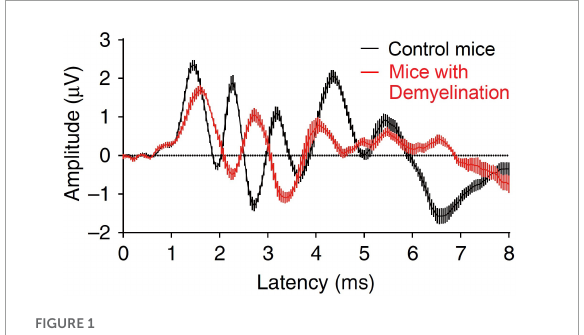
FIGURE1 Effect of demyelination on the mice auditory brainstem response. Figure adapted from Wan and Corfas (2017).